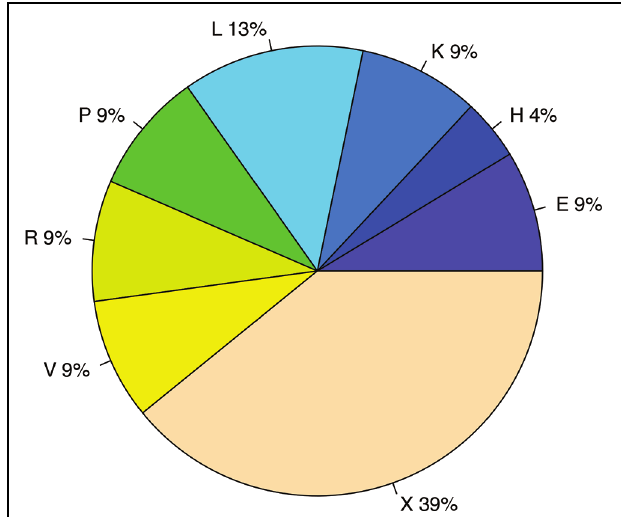
FIGURE 9 | COG functional categories enriched in genes with antisense transcription. The functional categories include E: Amino acid transport and metabolism; H: Coenzyme transport and metabolism; K: Transcription; L: Replication, recombination and repair; P: Inorganic ion transport and metabolism; R: General function prediction only; V: Defense mechanisms; and X: Mobilome, prophages,